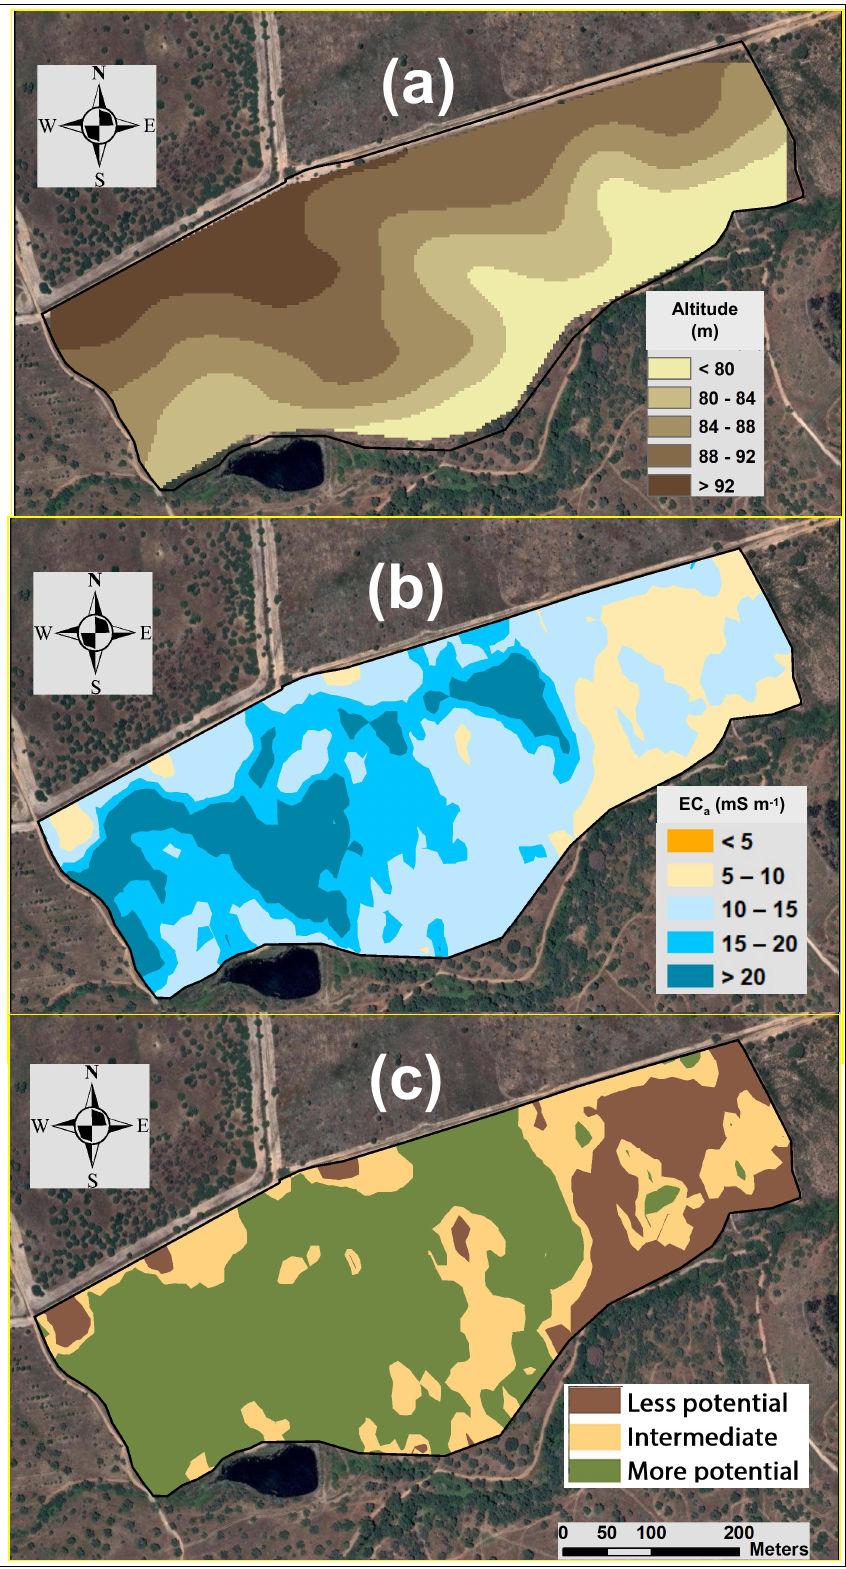
Figure 6. Altitude ( a ), soil apparent electrical conductivity (EC a ; ( b )) and homogeneous management zones ( c ) of “Azinhal” experimental field.